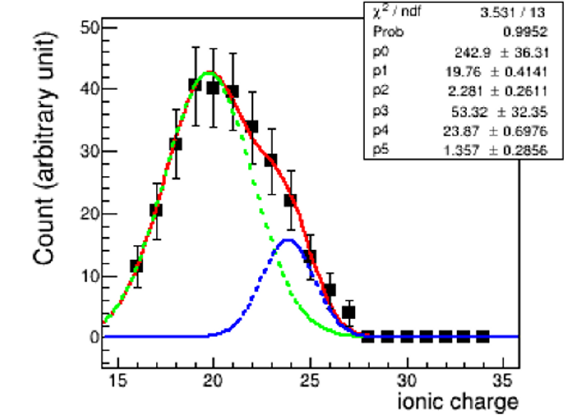
Fig. 5: Ionic charge distribution de-convoluted using the Gaussian assumption for the unconverted state according to the Betz model [19-20]. The blue curve corresponds to the ns-isomer